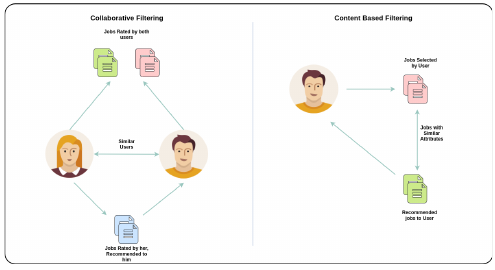
Fig. 1. Content-Based Filtering and Collaborative Filtering